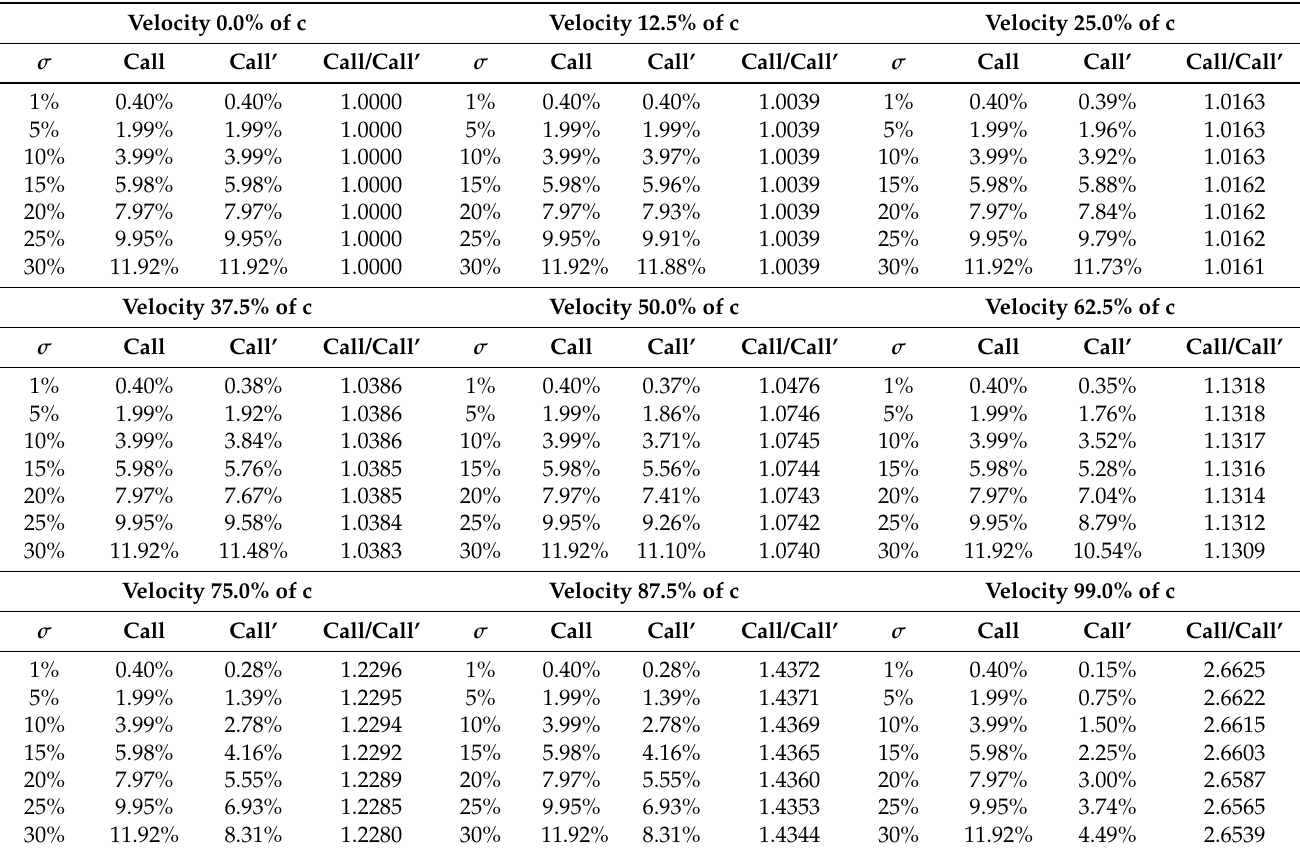
Table 2. Prices for Call , Call (cid:48) as well as the Call / Call (cid:48) ratio, for the volatilities 1.0%, 5.0%, 10.0%, 15.0%, 20.0%, 25.0% and 30.0%, for maturity T = 1 year, for the velocities 0.0%, 12.5%, 25.0%, 37.5%, 50.0%, 62.5%, 75.0%, 87.5% and 99.0% of c . For simplicity, we consider the values at inception t = 0 and r = 0% and both asset priced at inception and strike equal to one S = K =